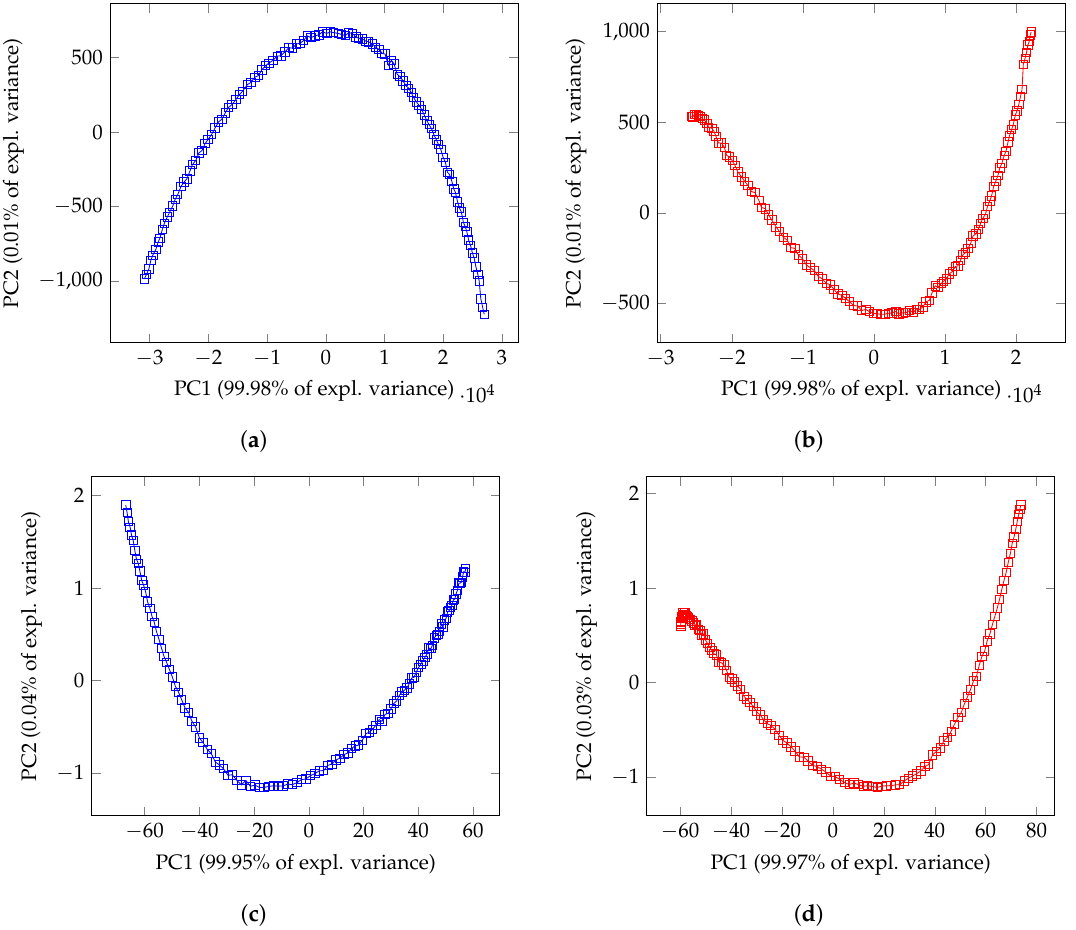
Figure 4. PC1 vs. PC2 scores during ramp up ( left ) and down ( right ) within CO 2 ( top ) and Xe ( bottom ) adsorption. ( a ) Ramped-down CO 2 PC1 vs. PC2. ( b ) Ramped-up CO 2 PC1 vs. PC2. ( c ) Ramped-down Xe PC1 vs. PC2. ( d ) Ramped-up Xe PC1 vs. PC2.